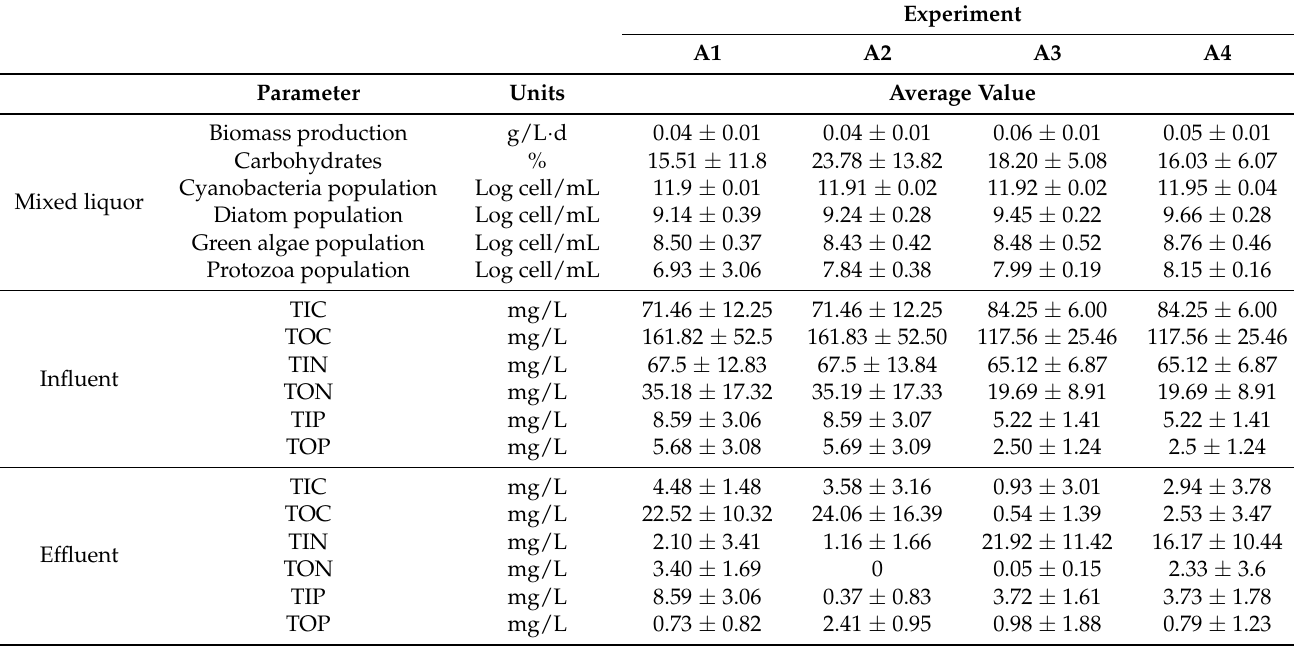
Table 2. Averages and standard deviations of water quality and biomass parameters in the influent, effluent, and mixed liquor used as model